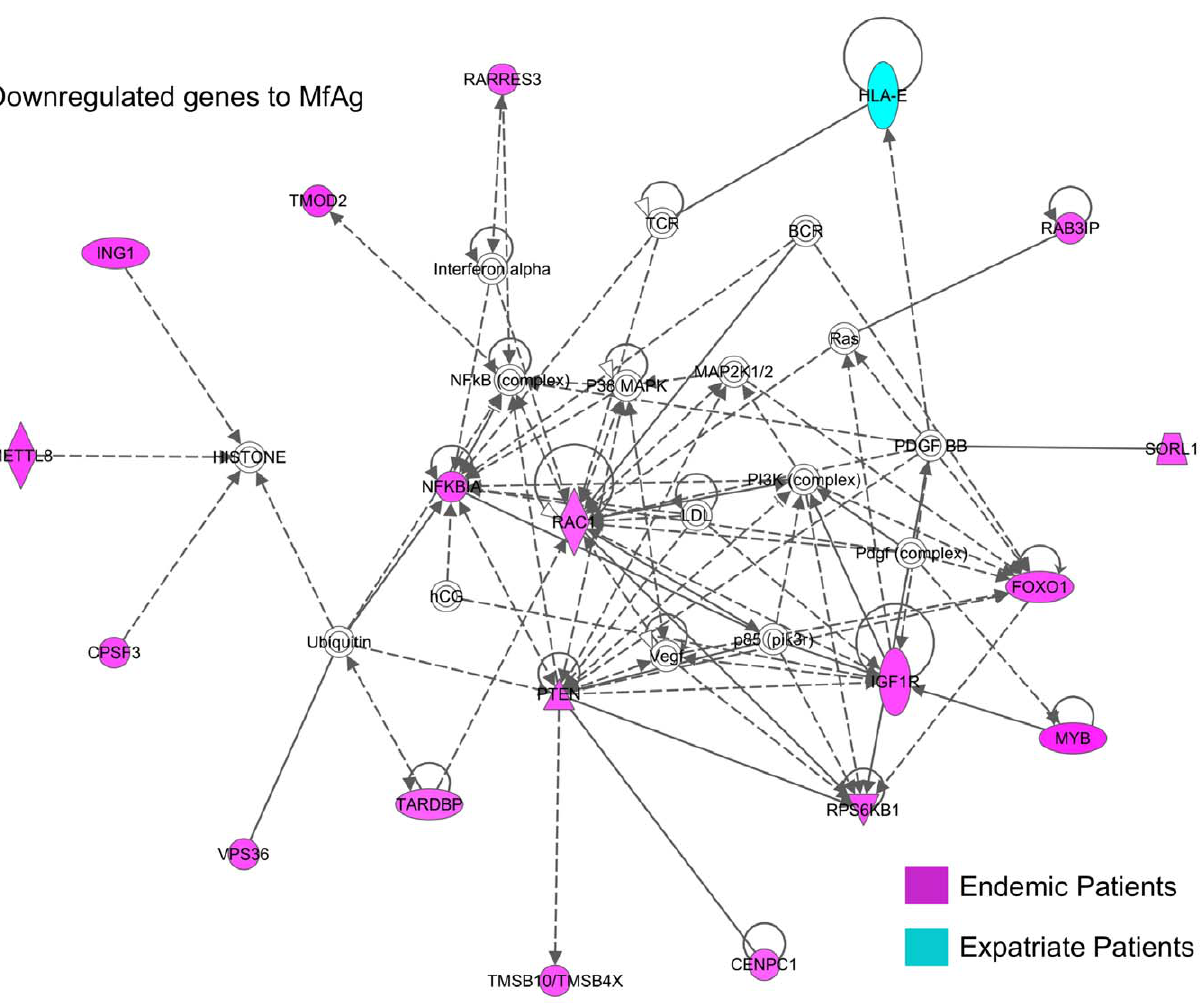
Figure 7. Network of microfilarial Ag-driven downregulated genes. Major network (www.ingenuity.com) of differentially expressed molecules that were significantly downregulated (p , 0.001) to MfAg in either CD4 + or CD8 + T cells of endemic (in red) and expatriate (in blue) patients. Lines represent direct (solid lines) and indirect (dashed lines) relationships between molecules and molecules within double circles represent complexes of